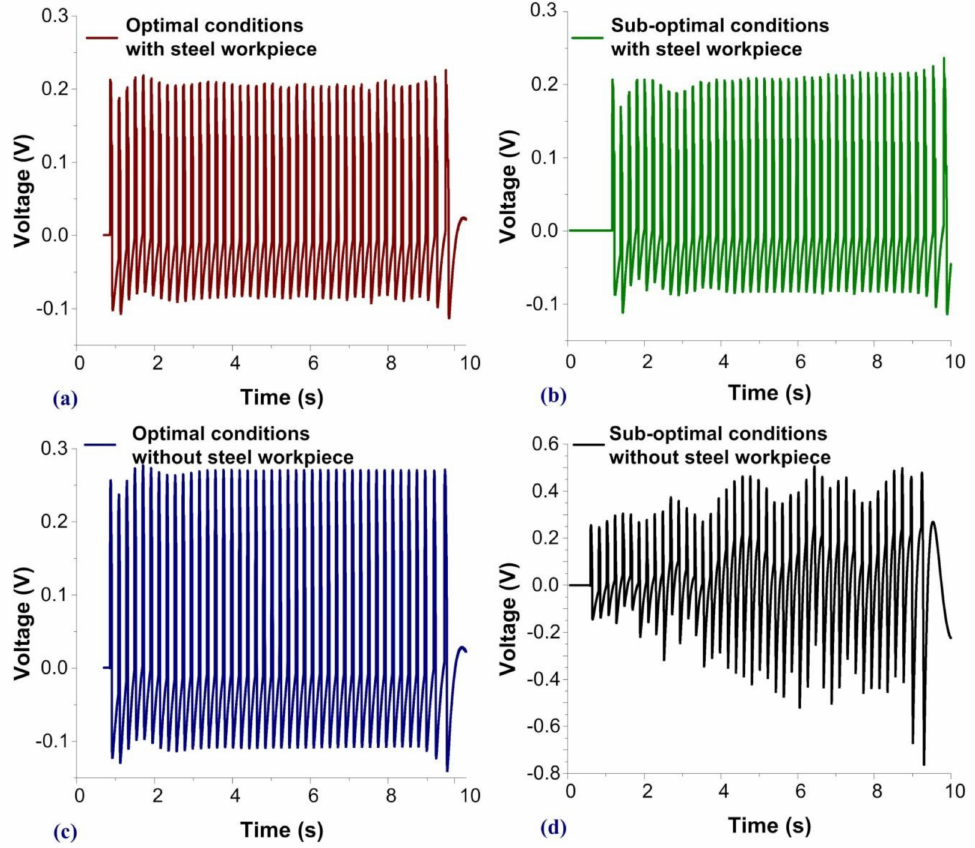
Figure 6. Comparison of PVDF waveforms at macroscale: signals obtained with a steel workpiece loaded into the notching machine with ( a ) sharp edges and ( b ) blunt edges; and signals obtained without a steel workpiece loaded into the notching machine with ( c ) sharp edges and ( d ) blunt